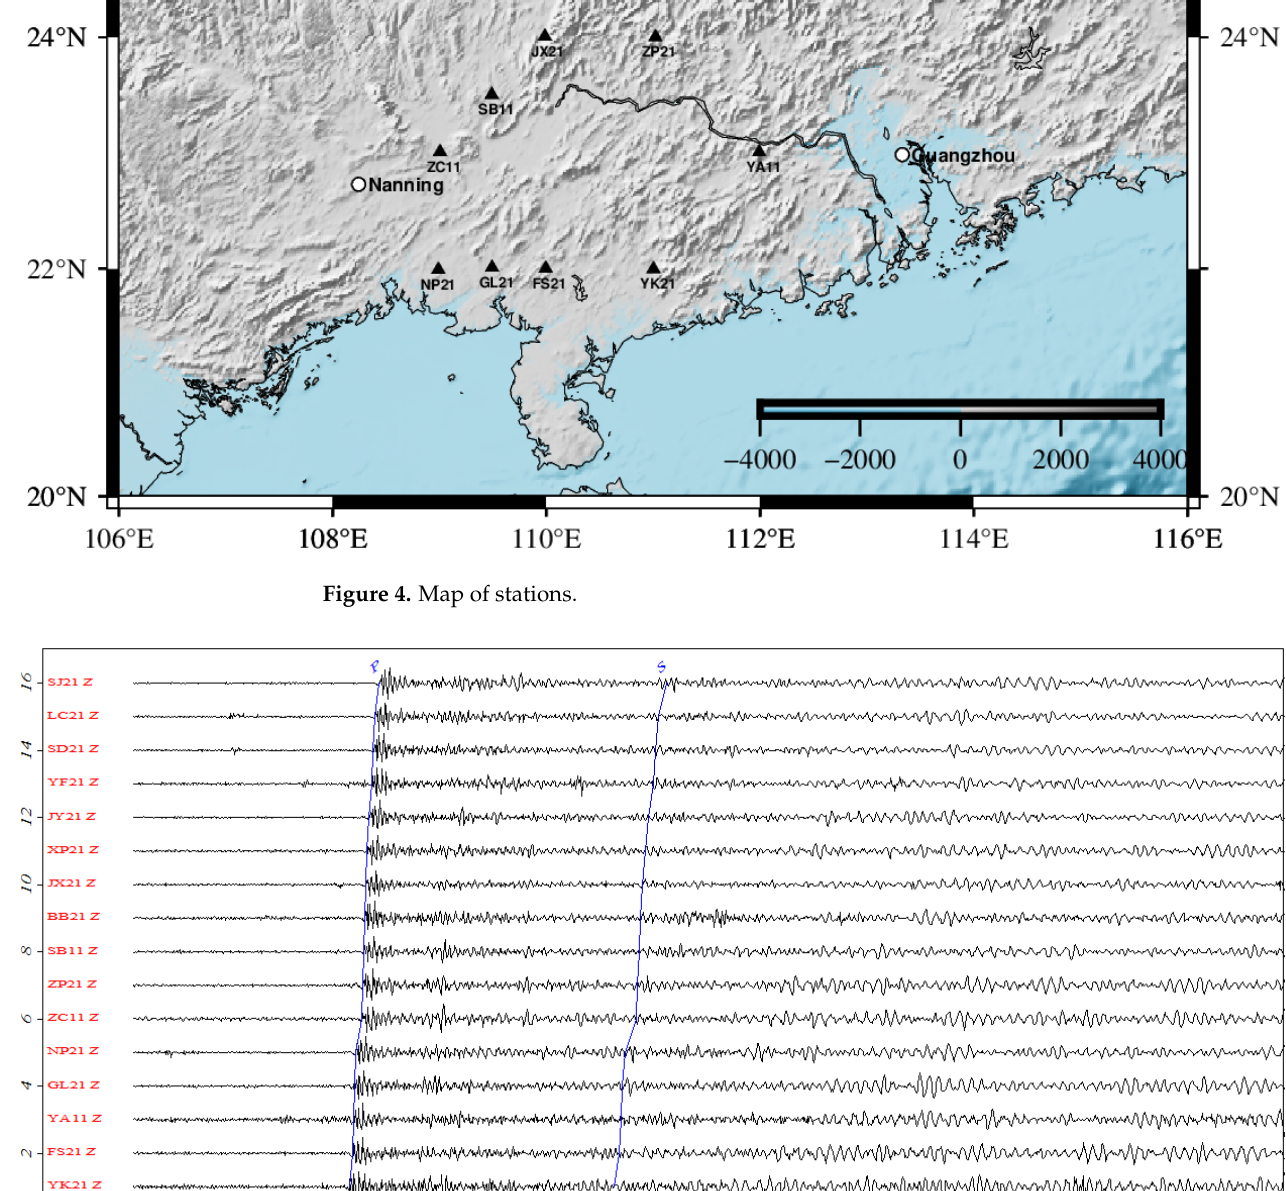
Figure 6. Brazilian earthquake records and theoretical arrival times of PKIKP, PKPab, SKIKP, PKIKS, PP, SKIKS, and PPP seismic phases. The selected reference wavelet (SB11 station is used as the reference wavelet in Figure 7; SD21 is used as the reference wavelet in Figure 8). Use a shorter wavelet wherever pos- sible to ensure the accuracy of the seismic phase picking. In general, the wavelet should not be longer than 15 s to prevent the wavelet from incorporating another seismic phase and influencing the accuracy of the travel time picking. The window length of the selected wavelets of other stations is set according to the length of the reference wavelet, so that the wavelets of other stations can be filtered to the best wavelets in the window set by the parameters (which will only be correlated within the window of the control parameters) even in the environment of low signal-to-noise ratio.